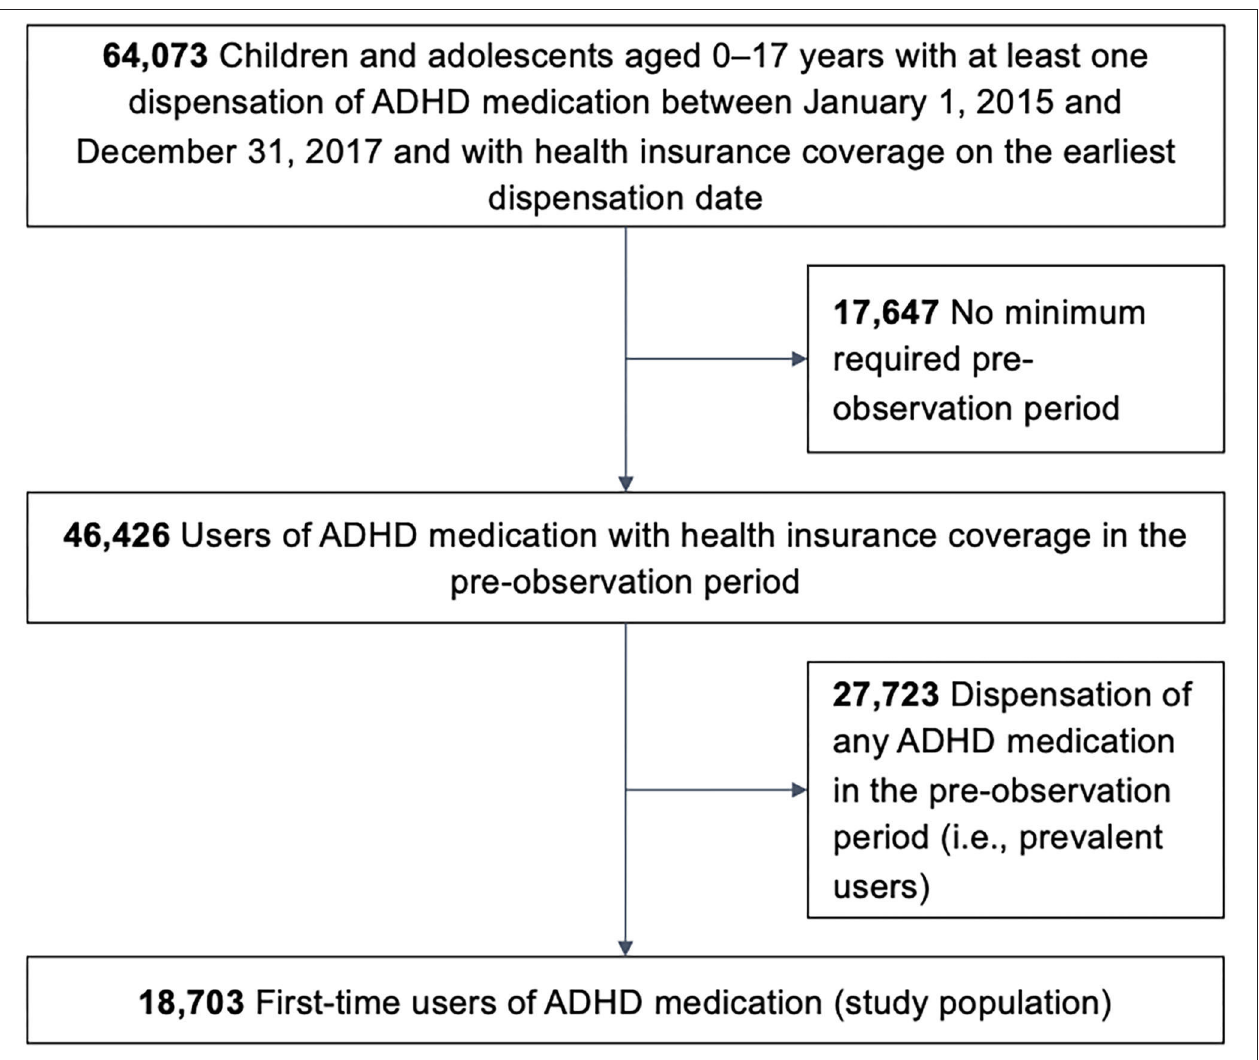
FIGURE 1 | Flow diagram. ADHD, attention deficit hyperactivity